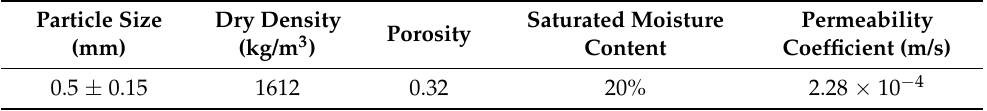
Table 1. Physical properties of the sand.